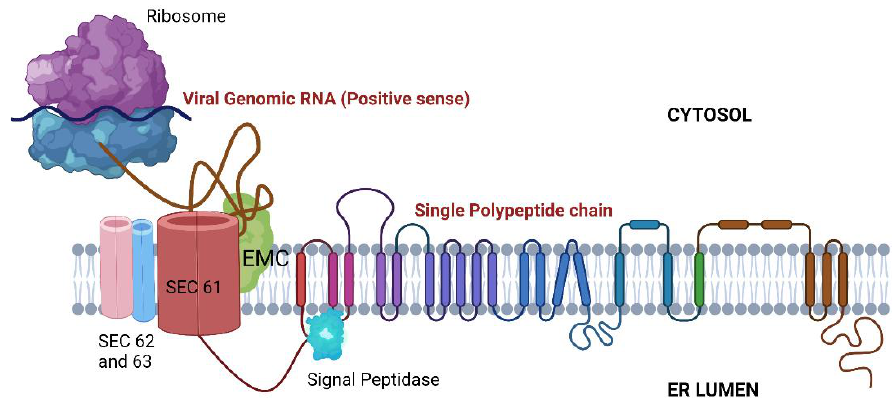
Figure 3. ER-associated proteins are involved in viral RNA translation, stabilization, and folding. SEC61: Translocon; EMC: Endoplasmic reticulum membrane protein complex.